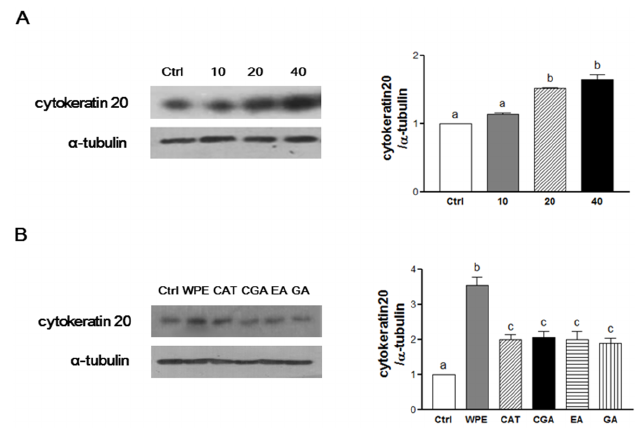
Figure 3. WPE and its bioactive compounds induce colon CSCs differentiation. CD133 + CD44 + HCT116 cells were treated with varying concentrations of WPE (0, 10, 20, and 40 µ g/mL) ( A ); or concentrations of (+)-catechin, chlorogenic acid, ellagic acid and gallic acid comparable to 40 µ g/mL of WPE ( B ) for 6 days. Expressions of cytokeratin 20 (CK20) was analyzed by Western blot analysis, and α -tubulin was used as a loading control. Representative blots are shown in left panel and quantified in right panel. The values shown are the means ˘ SEM. A p -value < 0.05 was considered significant. Ctrl, Control; WPE, walnut phenolic extract; CSCs, cancer stem cells; CAT, (+)-catechin; CGA, chlorogenic acid; EA, ellagic acid; GA, gallic